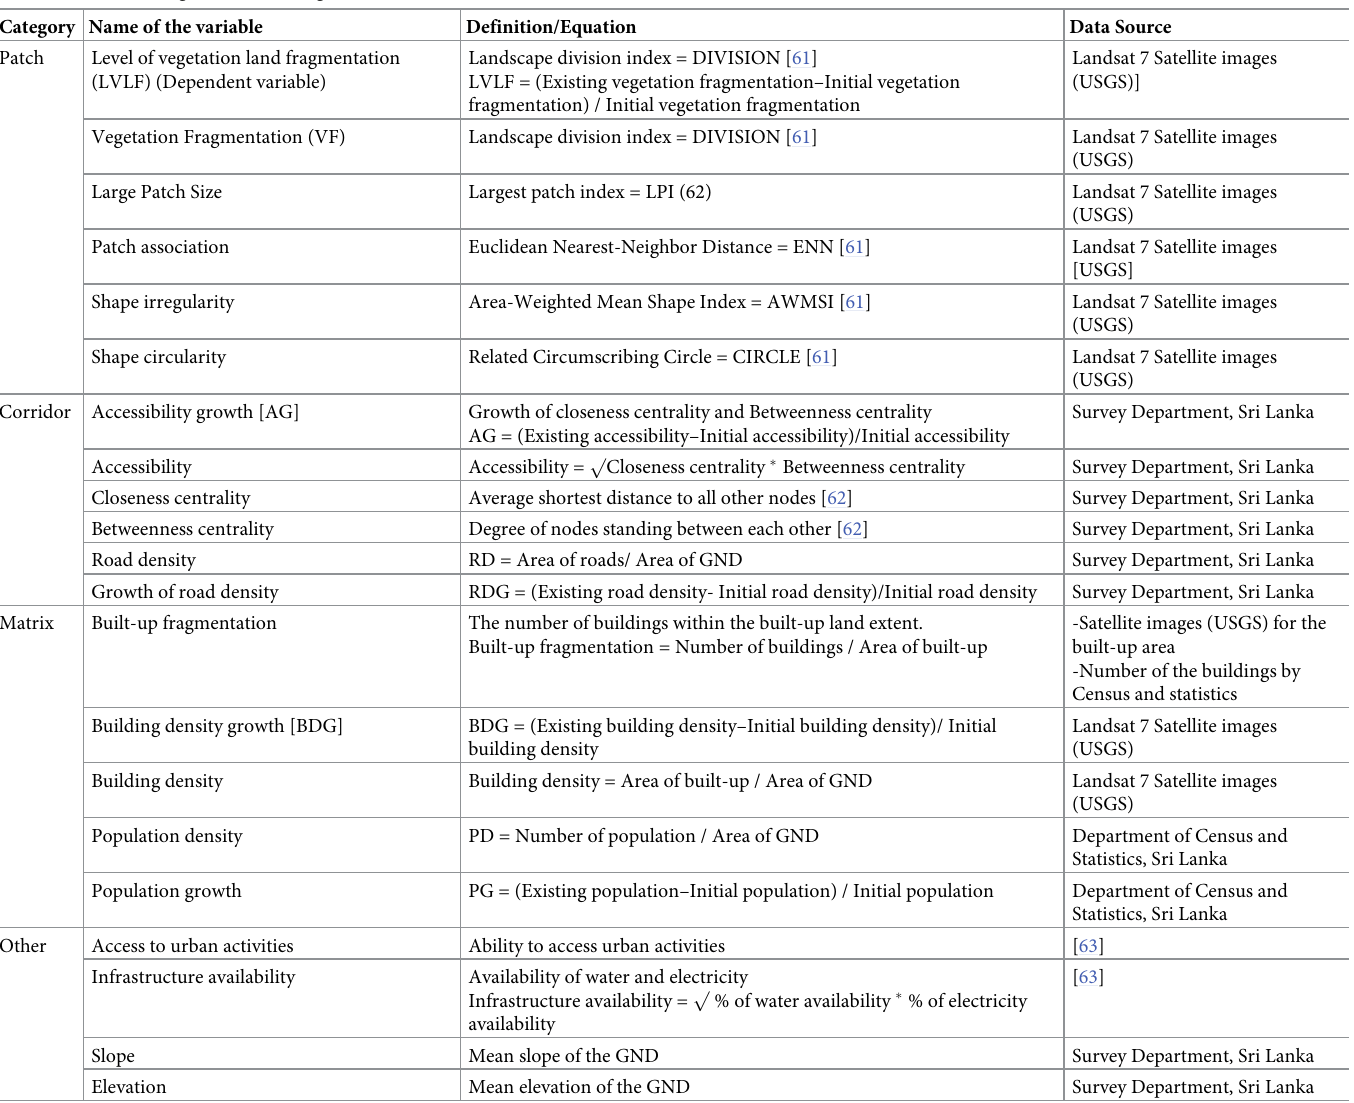
Table 1. Factors of vegetation land